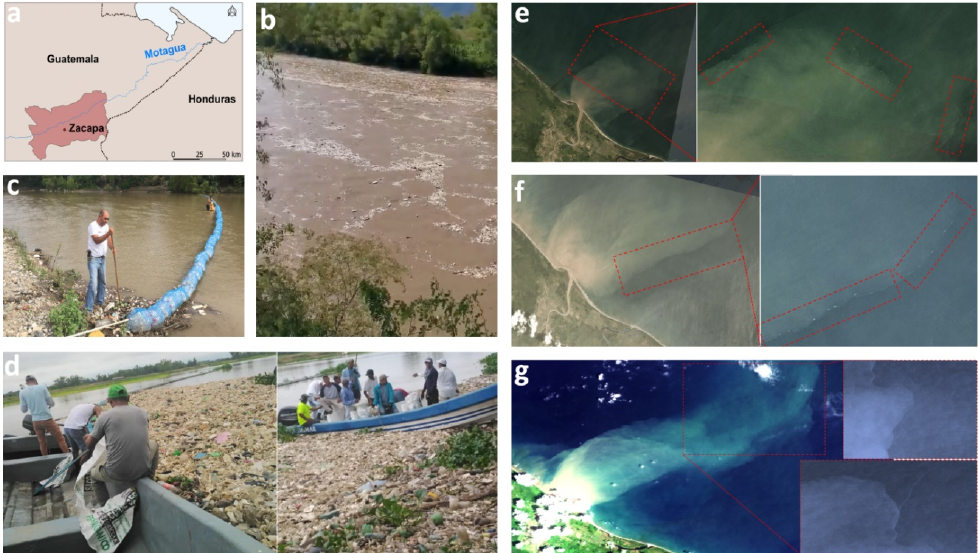
Figure 5. Detected floating plastic debris along the Motagua River in the Zacapa province of Guatemala and the corresponding discharges detected in satellite data during late August / September 2019. ( a ) Location of Zacapa city. ( b ) Recorded plastic debris along the Motagua River. ( c , d ) Plastics partially collected by booms, which managed to collect only a small amount of debris, since they were rapidly overwhelmed and debris overpassed them. ( e ) Detected plastic discharges at the Motagua River mouth on a Planet image (3/9/2018). ( f ) Same as ( e ) but on 6 September 2018. ( g ) Detected plastic debris in Motagua River mouth on Landsat-8 data (18/9/2018). Julio R Guzman Perdomo acquired the photos ( b ), ( c ) and ( d ) of this figure.